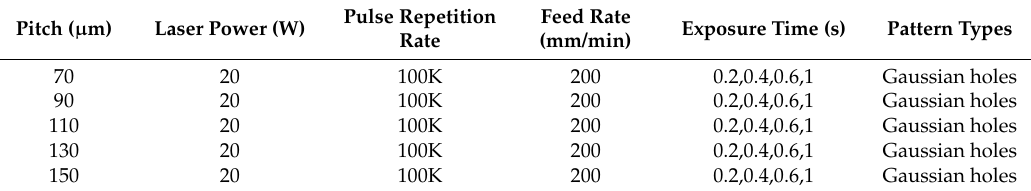
Table 3. The laser machining parameters with varied exposure time and pitch.